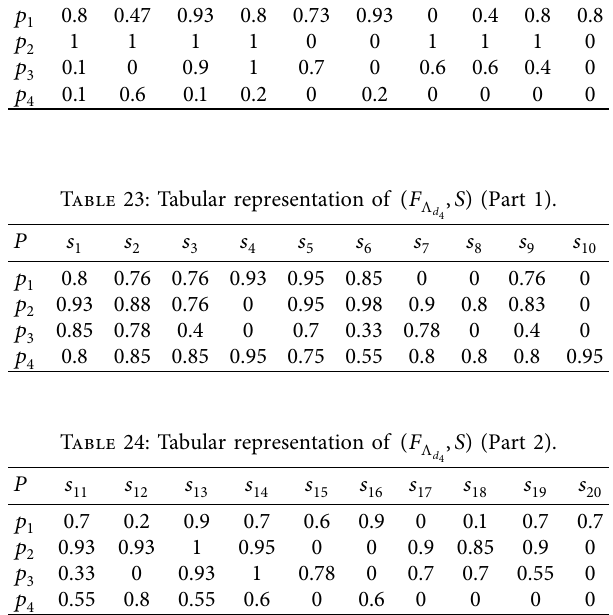
Table 22: Tabular representation of ( F